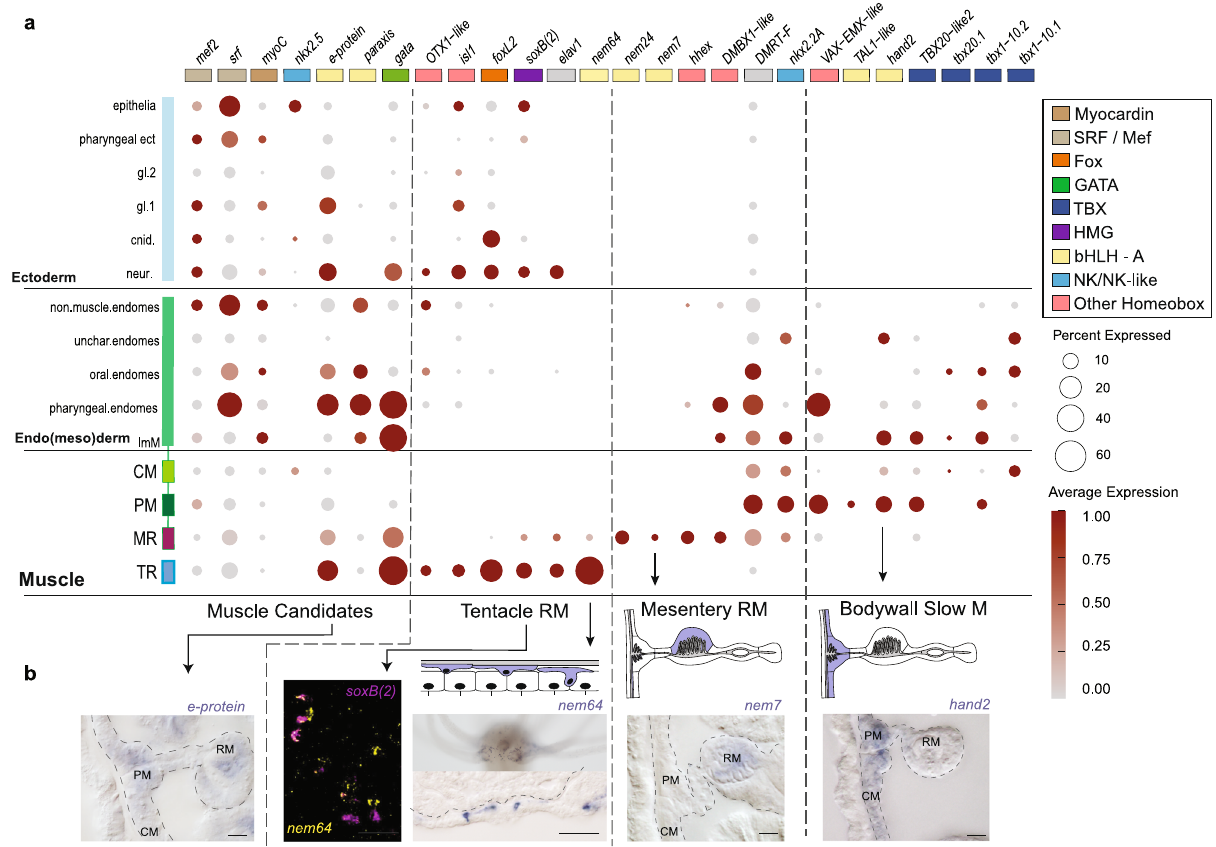
Fig.3|Regulatorypro fi lesofmusclecellsindicatebHLHcomplexaskeytocell type individuation. a Dot plot showing relative expression pro fi les of selected regulatory genes across the entiredataset. Ectodermalderivatives are indicated in blue.Genefamilyrelationshipsareindicatedaccordingtothecolorschemeshown